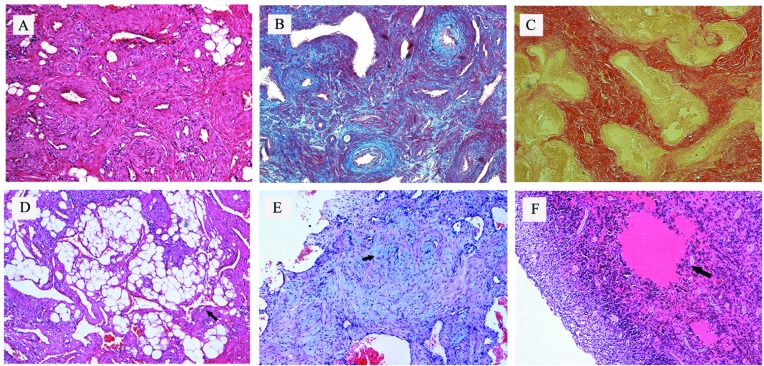
Angioleiomyoma tissue stained with H&E, Masson’s trichrome and Van Gieson stains. (A) The angioleiomyoma comprised of rich vascular channels with thick vessel walls and smooth muscle bundles with elongated nuclei (magnification, ×100). (B) Masson’s stain showing smooth muscle fibers in red, erythrocytes in blue, collagen fibers in black and nuclei in black-blue (magnification, ×100). (C) Van Gieson stain showing smooth muscle fibers in red and collagen fibers in yellow (magnification, ×100). (D) Groups of mature fat cells observed by H&E staining (magnification, ×100). (E) Focal myxoid change (black arrow) in the lesion, stained blue with H&E staining (magnification, ×100). (F) Hyaline change (black arrow) observed by H&E staining (magnification, ×100). H&E, hematoxylin and eosin.